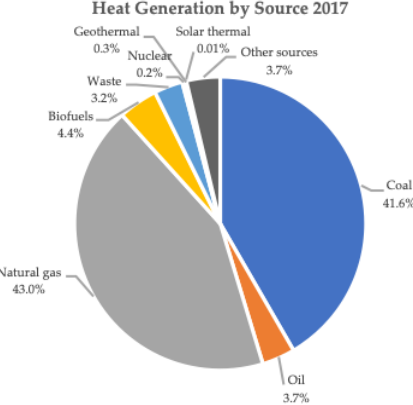
Figure 7. Heat Generation by Source 2017 (Source: IEA).